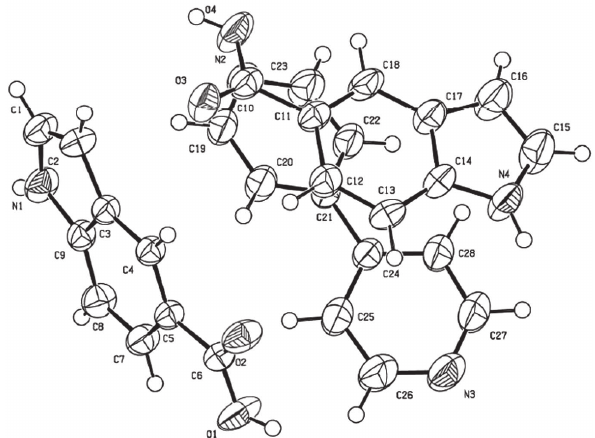
Table 2: Fractional atomic coordinates and isotropic or equivalent isotropic displacement parameters (Å 2